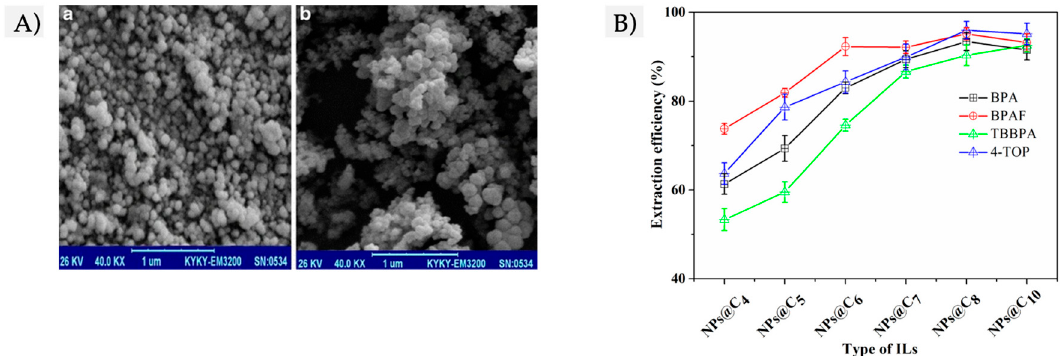
Figure 3. ( A ) SEM images of ( a ) Fe 3 O 4 -based magnetic nanoparticles (MNPs), and ( b ) silica-coated Fe 3 O 4 -based MNPs, used for the preparation of an ionic liquid (IL)-based FF. Figure adapted from [23] with permission of Springer. ( B ) Comparison between the extraction efficiencies obtained with different IL-based FFs with the same MNPs but different IL types (modifying the length of the alkyl chain of the IL cation), tested with a group of four endocrine-disrupting phenols. Figure adapted from [26] with permission of Elsevier.